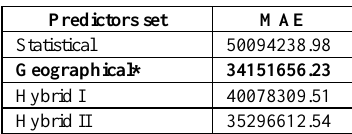
Table 3. The mean absolute error of imputation models (K-NN approach) based on sets of predictors.